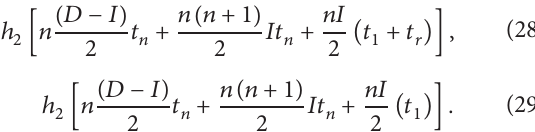
In the proposed study, the retailer’s stock holding posi- tions are illustrated in Figure